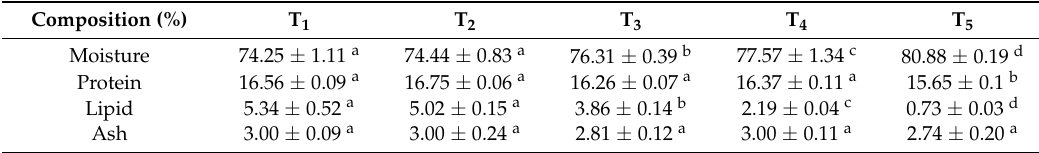
Table 3. Fish carcass proximate composition of Thai silver barb B. gonionotus (% in wet weight) in different feeding treatments after 56 days.